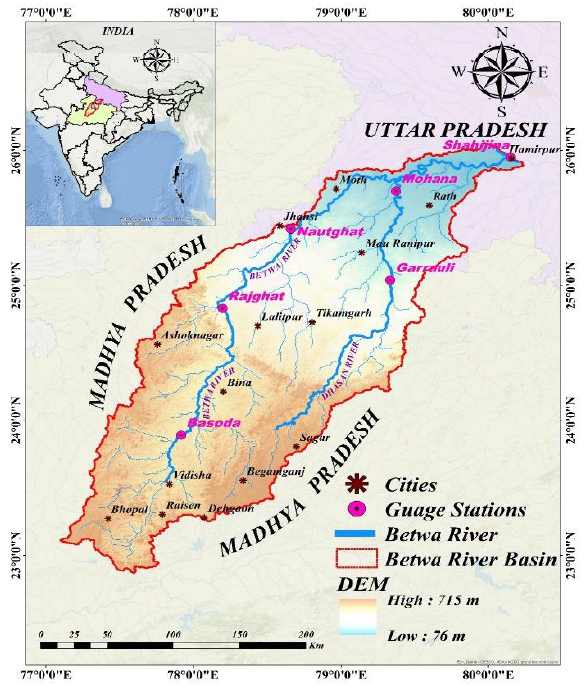
Figure 1. Location map of the Betwa River basin shows the topographic variability, drainage network, and respective gauge stations.